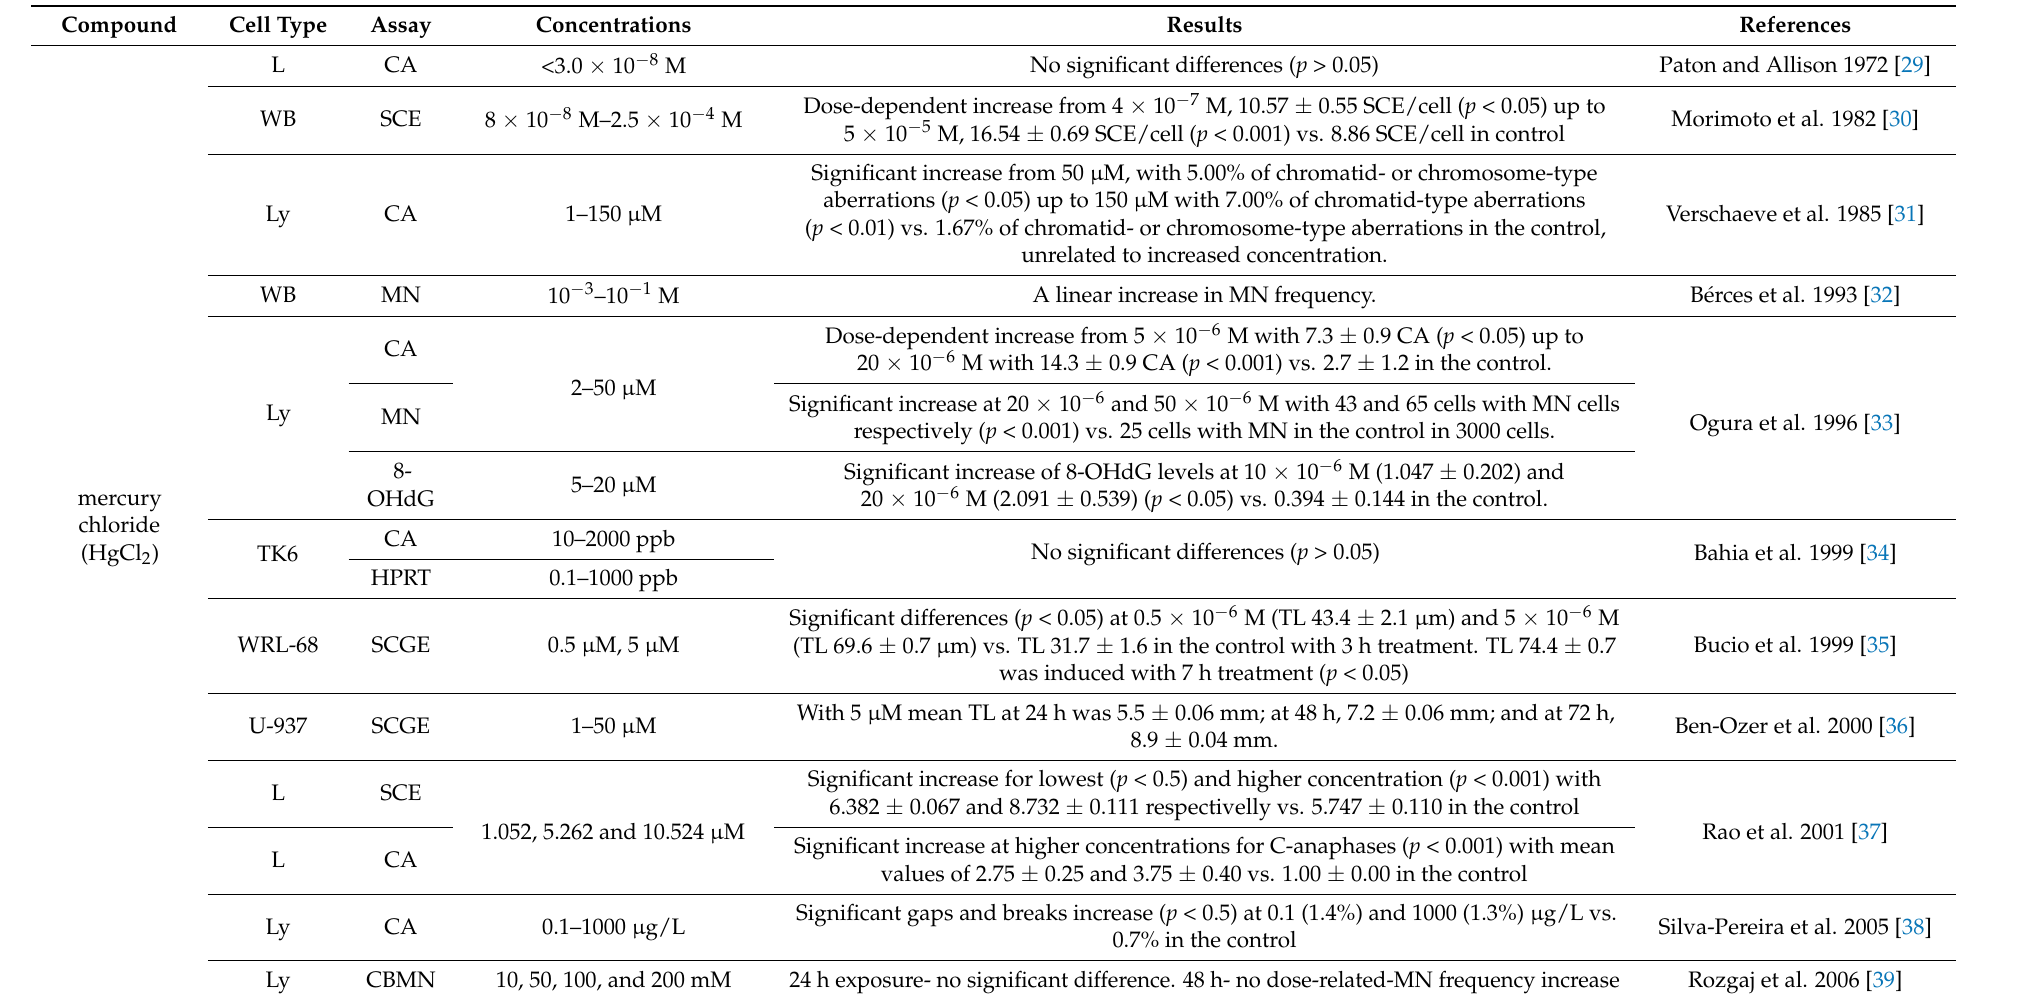
Table 1. Studies on in vitro genotoxic effects by inorganic Hg